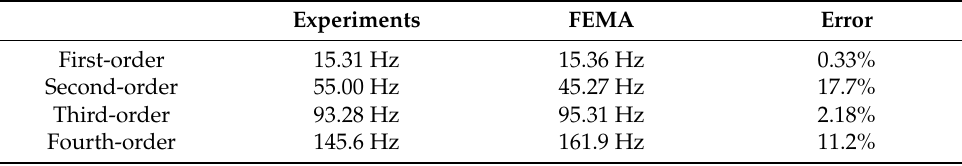
Table 1. Comparison of natural frequency between experiments and finite element model analy- sis